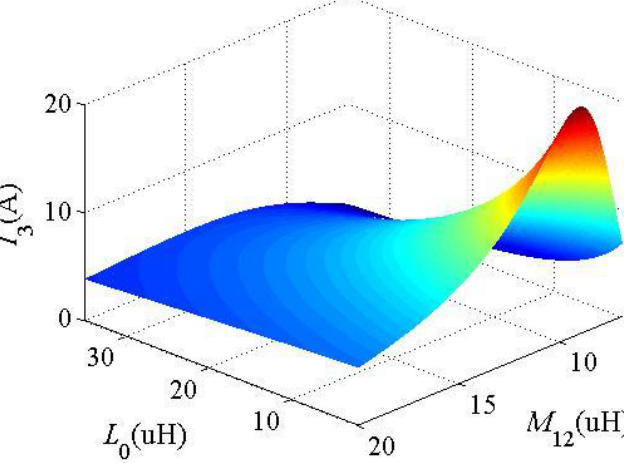
Figure 7. Profile of fitness with respect to particle generation.